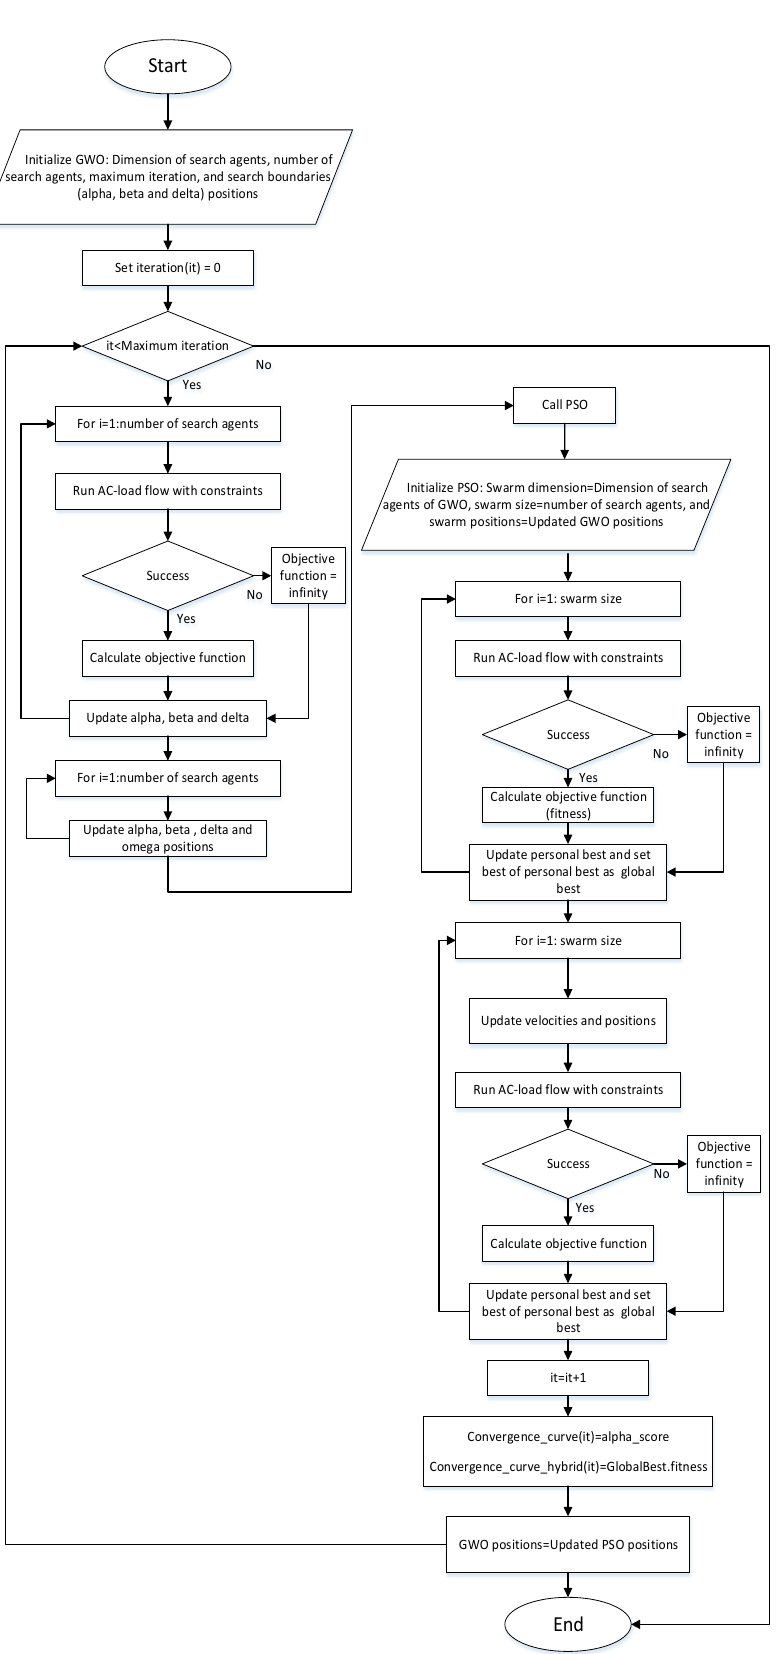
Figure 1. Flow chart of the hybrid GWO-PSO.